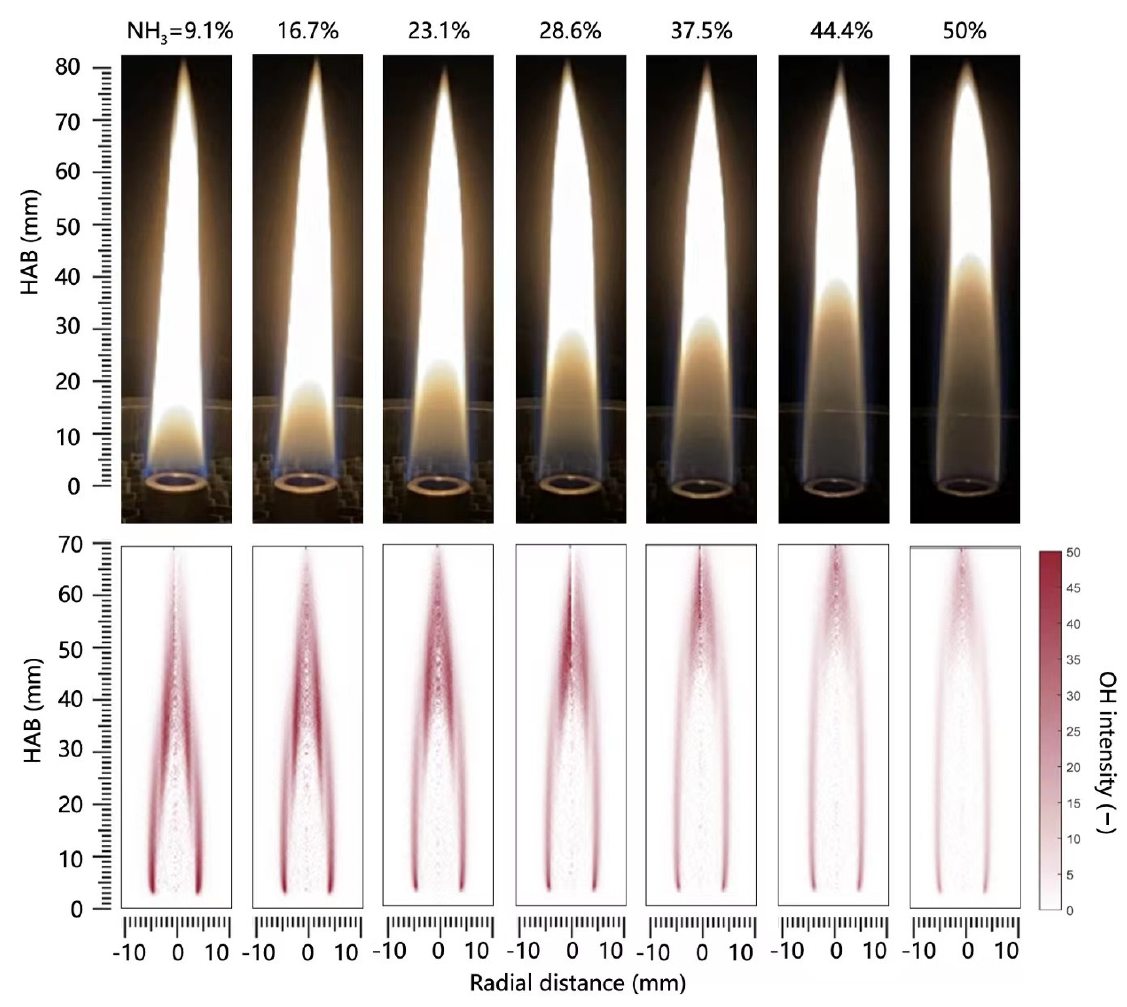
Figure 3. Flame images and the corresponding OH* chemiluminescence images of ethylene diffusion jet flame doped with ammonia at different volume percentages.